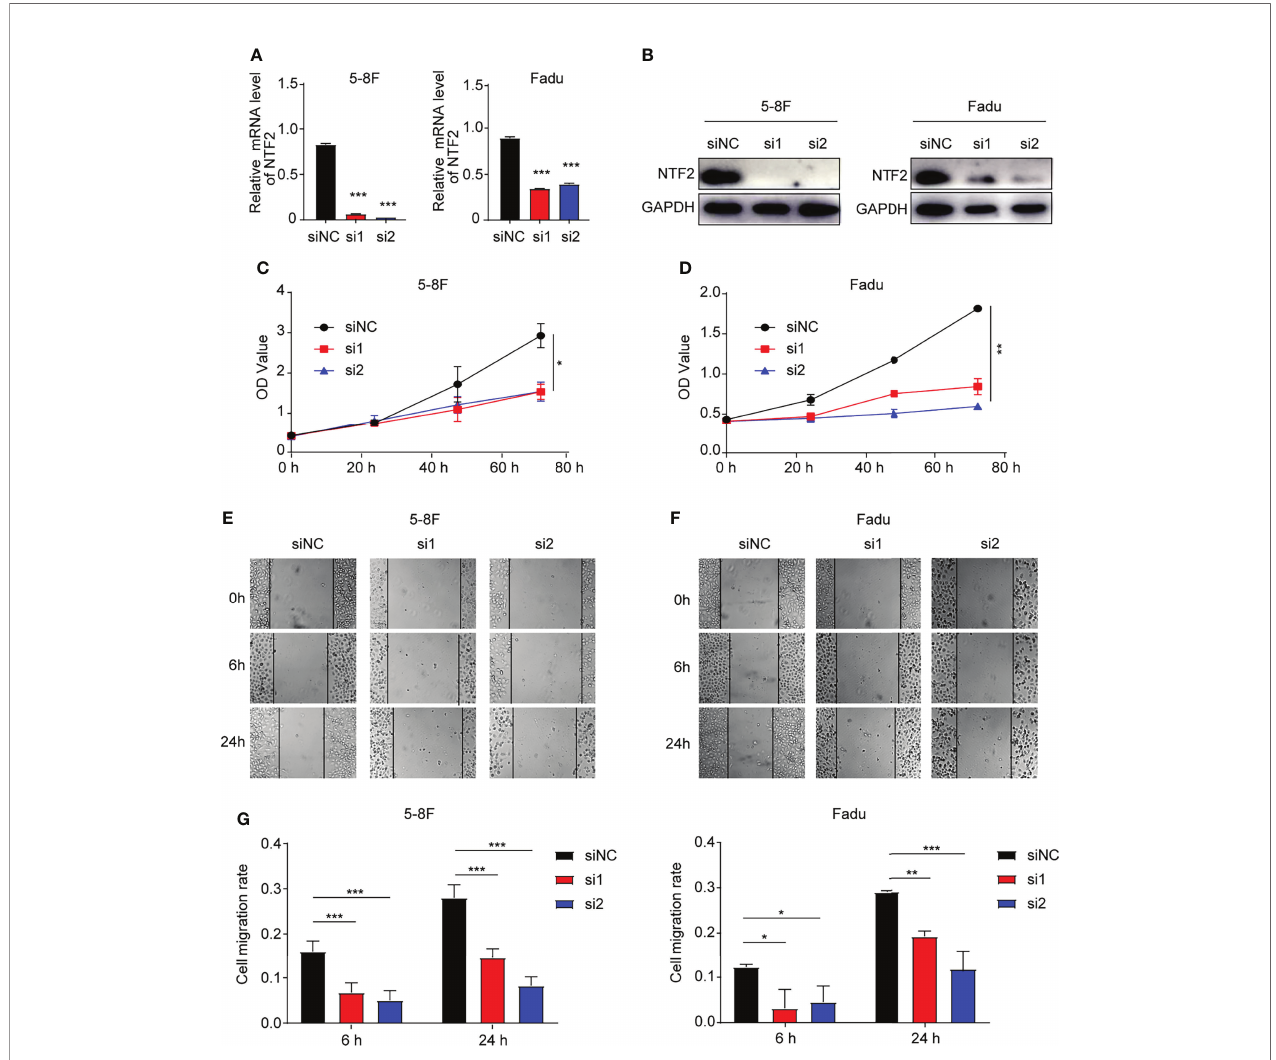
FIGURE 7 | Experimental validation. (A, B) Knockdown validation by qRT-qPCR and western blotting. CCK-8 assay (C, D) and wound-healing assay (E, F) were used to detect the growth and migration of NTF2-knockdown HNSCC cell lines. *P < 0.05, **P < 0.01, ***P <